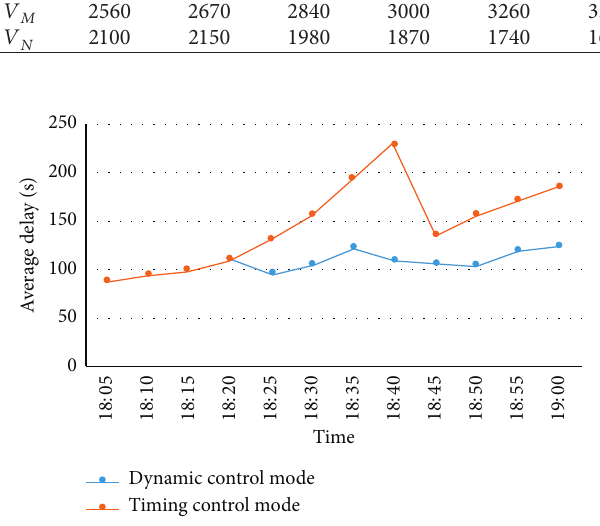
Figure 7: Comparison of average delay of dynamic control mode and timing control